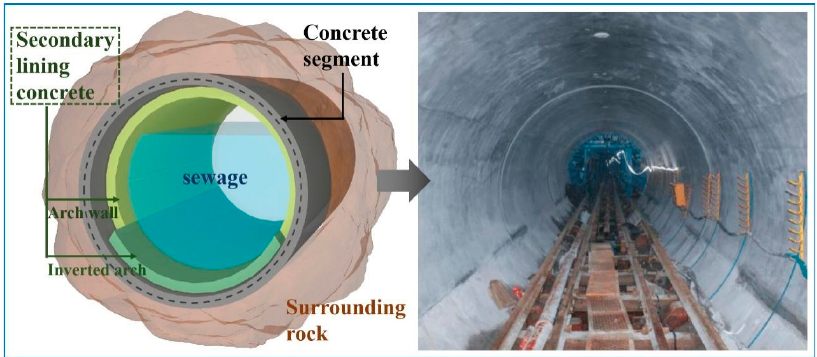
Figure 1. Schematic diagram of secondary lining engineering of underground tunnel.